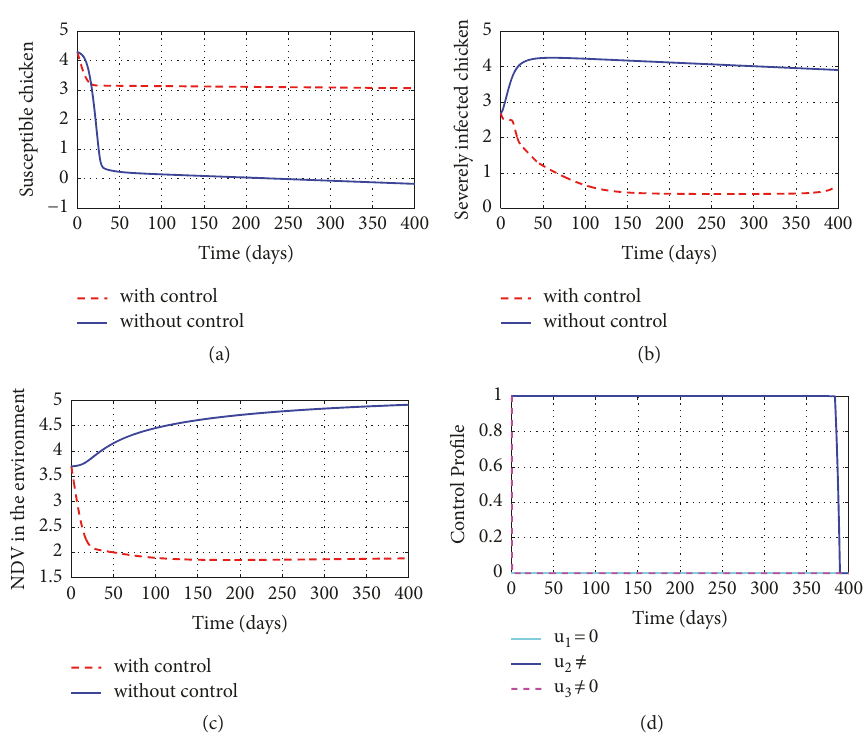
Figure 6: Optimal solutions for model variables 𝑆 𝑐 , 𝐼 𝑐 , 𝐻 and the control profiles for 𝑢 1 , 𝑢 2 , 𝑢 3 with ( 𝑢 1 = 0 , 𝑢 2 ̸= 0 , 𝑢 3 ̸= 0